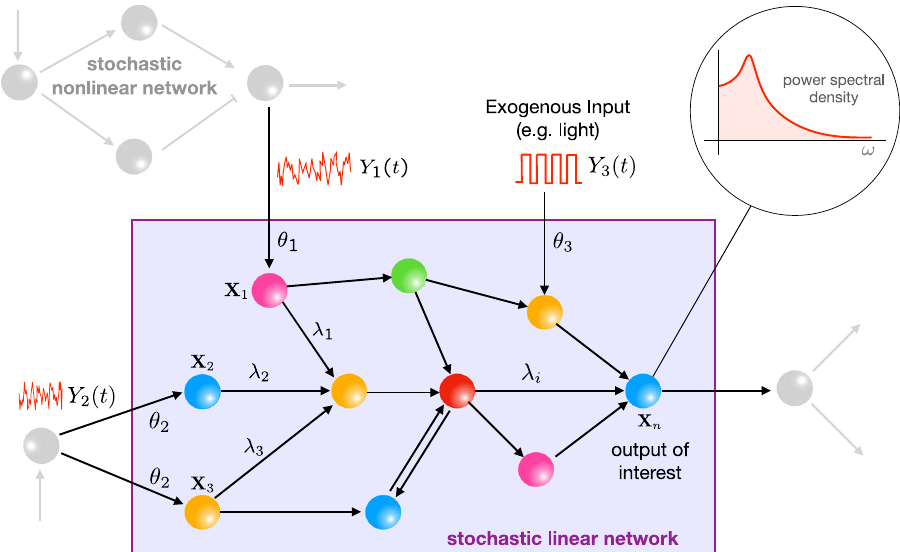
Fig. 1 The setting of the PSD decomposition result. A stochastic reaction network with linear propensity functions embedded in the intracellular milieu and receiving stimulation from several upstream networks. Theorem 2.1 provides an analytical decomposition for the output PSD S X PSDs of all the stimulating